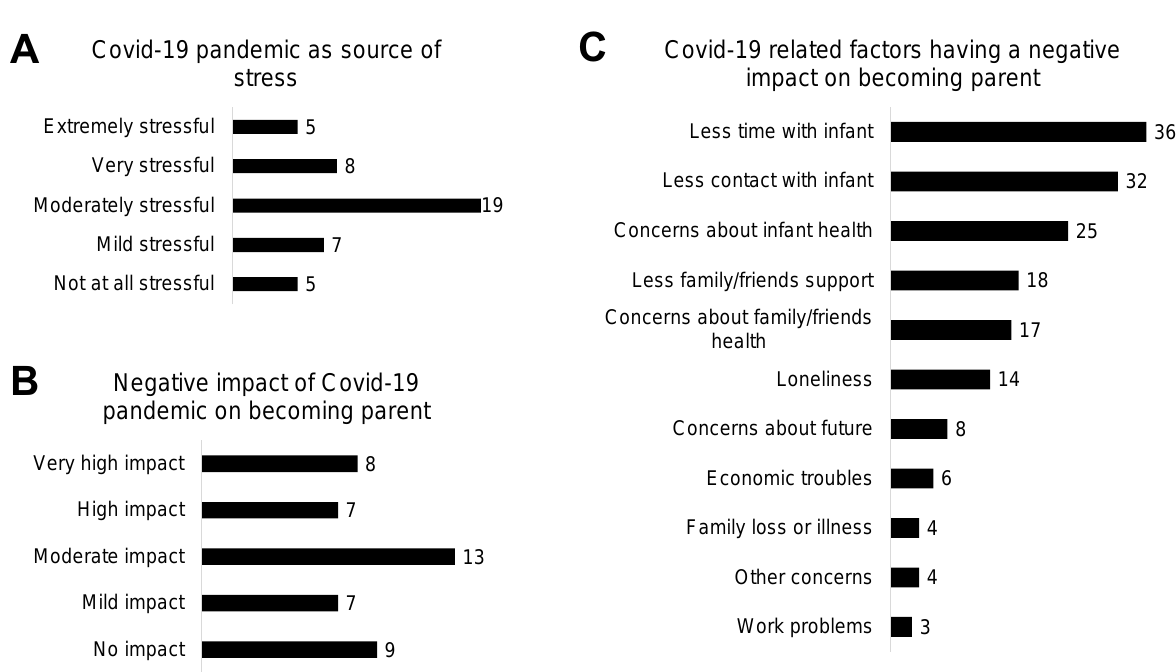
Figure 1. COVID-19 related parental stress: COVID-19 as source of stress ( A ), negative impact of COVID-19 on becoming a parent ( B ) and COVID-19 related factors having a negative impact on becoming a parent ( C ).